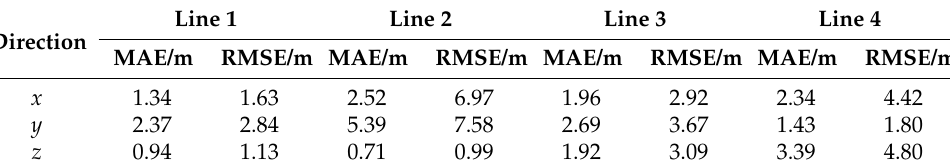
Figure 8. Error distribution of positioning results.